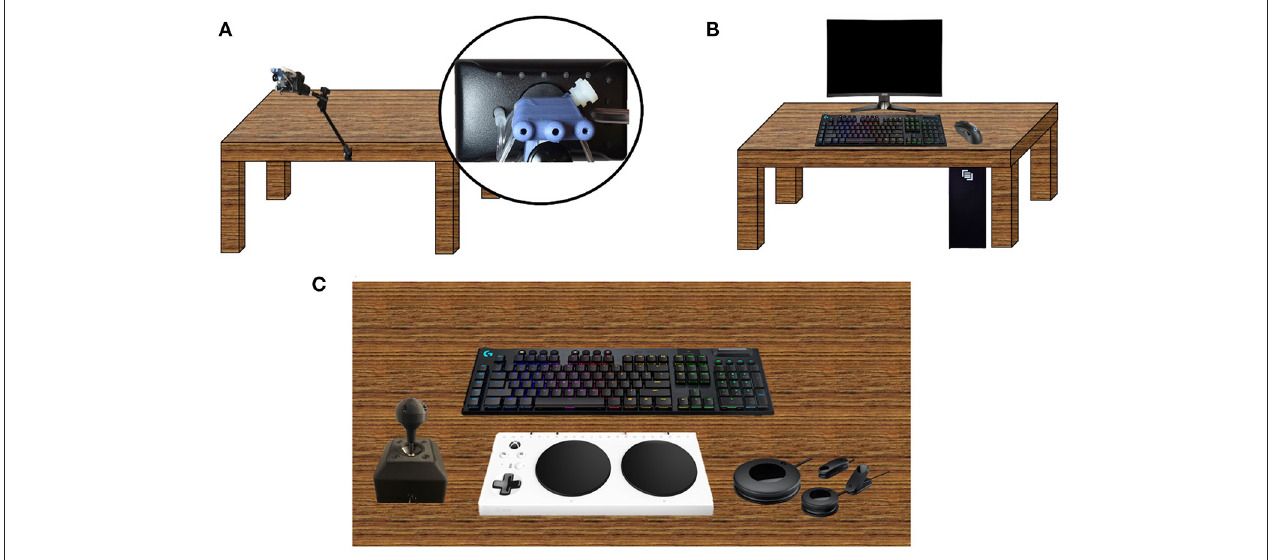
FIGURE 1 | Gaming setups. (A) Gaming setup of P1 and P6 using a QuadStick device. The Quadstick requires only the use of the head and neck. The QuadStick utilizes a coded mapping of sips and puffs to controller commands on a gaming system (Xbox, Playstation, or PC). There are three main tubes into which a user can sip or puff. Each sip or puff corresponds with a command on the gaming system and is controlled through oral orbicularis and diaphragmatic muscle activation. The sip and puff tubes are mounted on a joystick that is controlled through cervical movement (rotation and flexion/extension). The QuadStick sensor sensitivity can be tailored according to each individual’s neck movement and sip/puff intensity. The joystick movement corresponds with movement of the player’s character in the game. Multiple different controller mappings can be uploaded to the QuadStick at one time and the user is able to dynamically switch between them through the use of a side sip and puff tube. See Supplementary Figure 1 for an example of the button mapping used by the two QuadStick players presented here. (B) Original gaming setup of P2, P3, P5, and P7 using the Logitech keyboard and mouse with the MSI Optix screen (C) P4’s current gaming setup. This setup includes a combination of the Xbox Adaptive controller, the Logitech Adaptive Gaming Kit, one joystick from Warfighter Engaged, and the Logitech